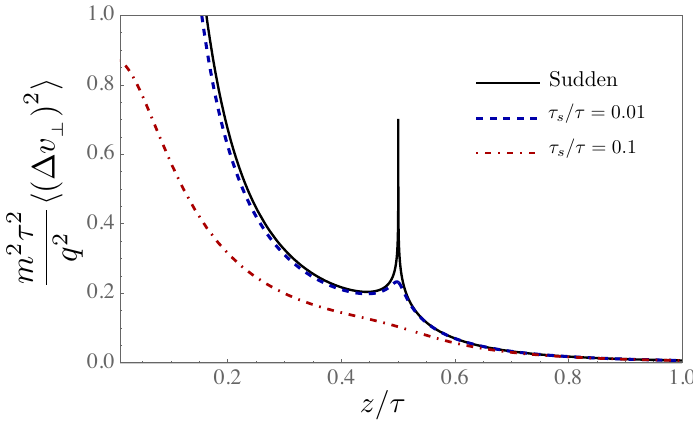
Figure 3 . Dispersion of the perpendicular component of the particle velocity, described by eq. (3.3), as function of z=(cid:28) for some suggestive values of the ratio (cid:28) s =(cid:28)